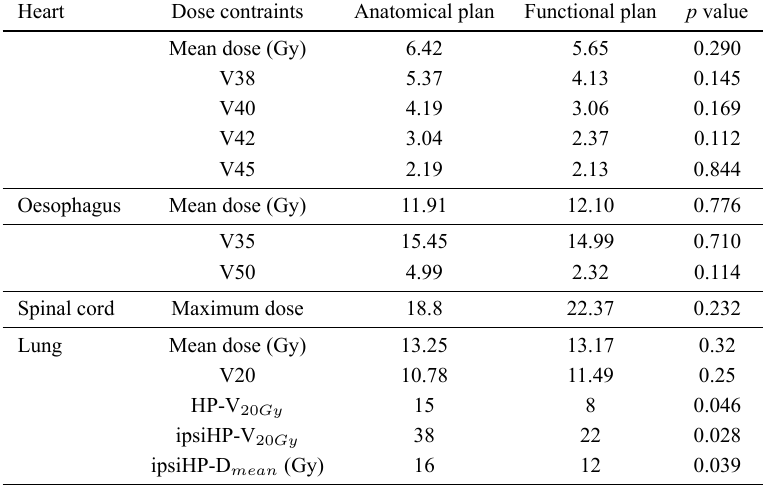
Table 4. Differences in the OARs metrics in anatomical and functional plan. Heart Anatomical